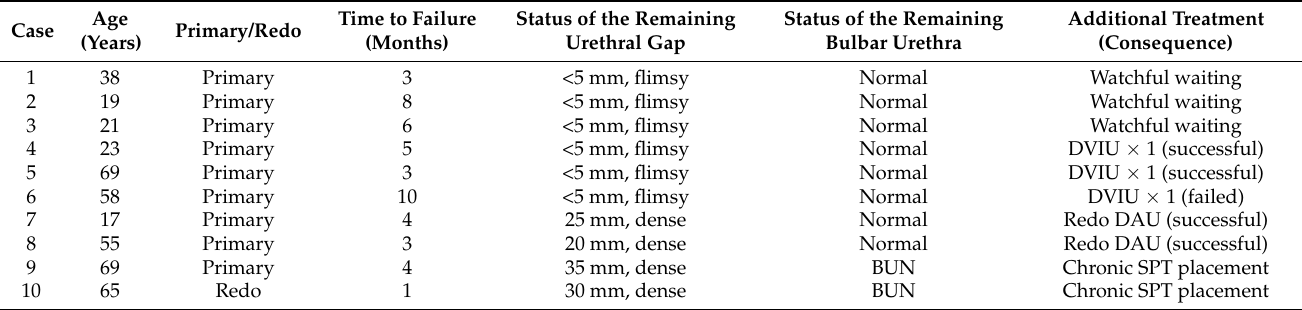
Table 3. Clinical characteristics of patients with failed DAUs.